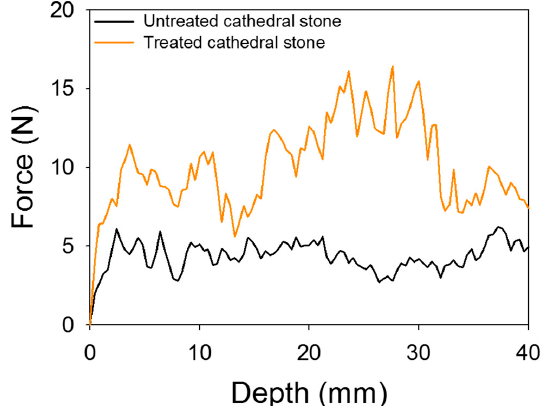
Figure 9. Drilling resistance versus testing depth of UCA-TS + F treated stone and its untreated counterpart.